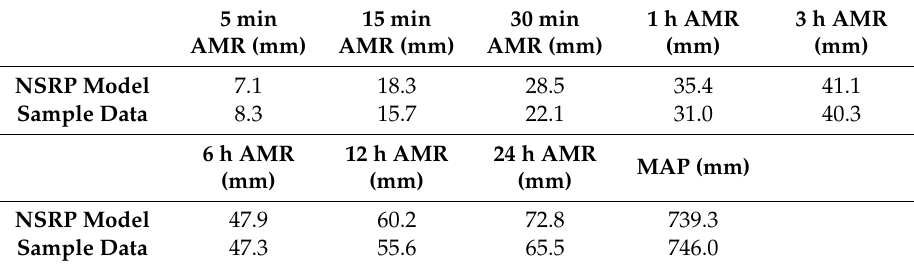
Table 3. Viterbo rain gauge: sample and NSRP mean values for the investigated time series.